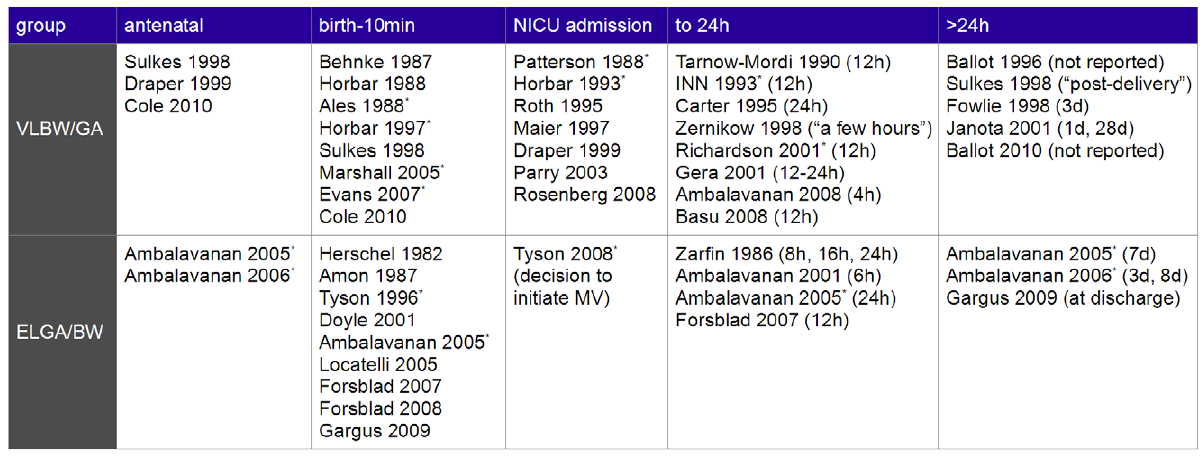
Figure 2. Classification of studies by the time at which a prediction can be made. Summary of prediction models by time of prediction. The time of prediction is the point in time where a prediction can be made using the model. A model for antenatal prediction was reported in 5 studies, for prediction at live birth in 17 studies, upon NICU admission in 8 studies, from the first day of life in 12 studies, and after the first day of life in 6 studies. Two studies do not specify when the data should be collected or when a prediction can be made. Studies marked with an asterisk met our criteria for methodological quality.